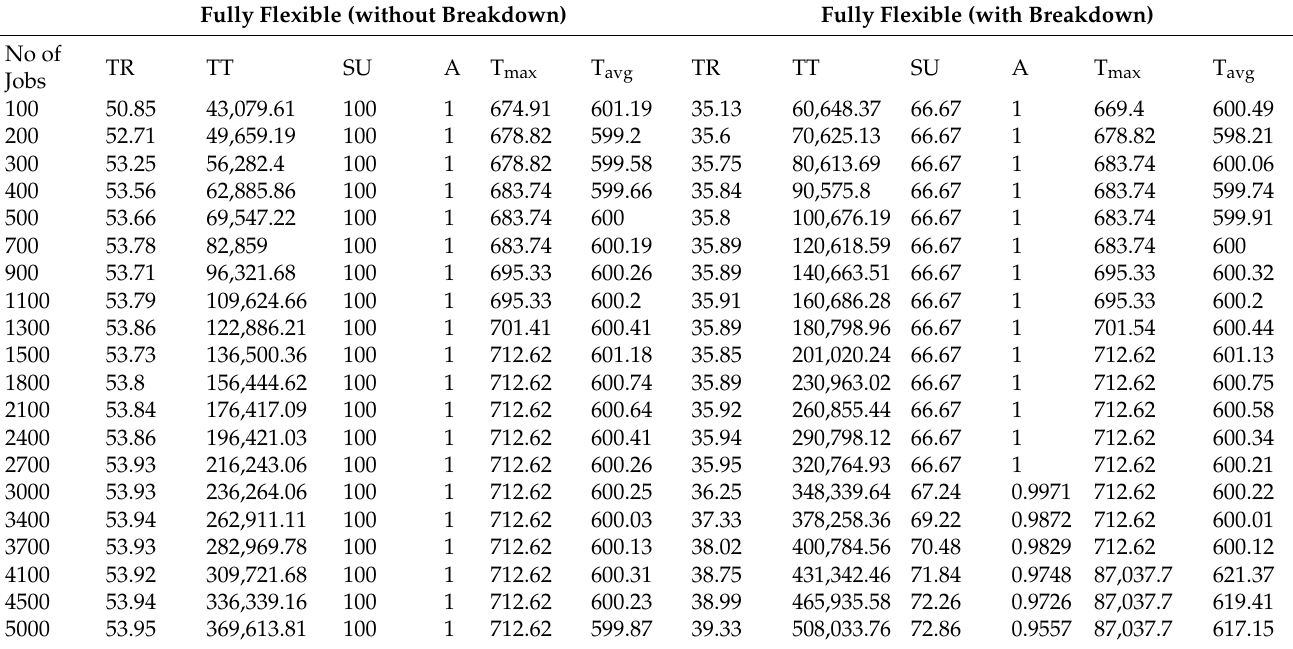
Table 6. Comparative Simulation Matrix of fully flexible configuration by without and with break- down of